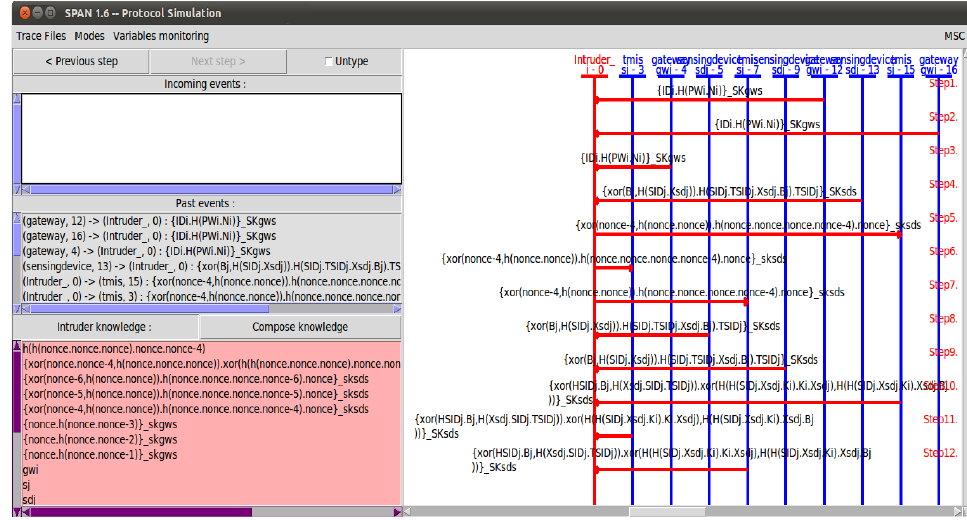
Figure 2. AVISPA result based on SPAN.